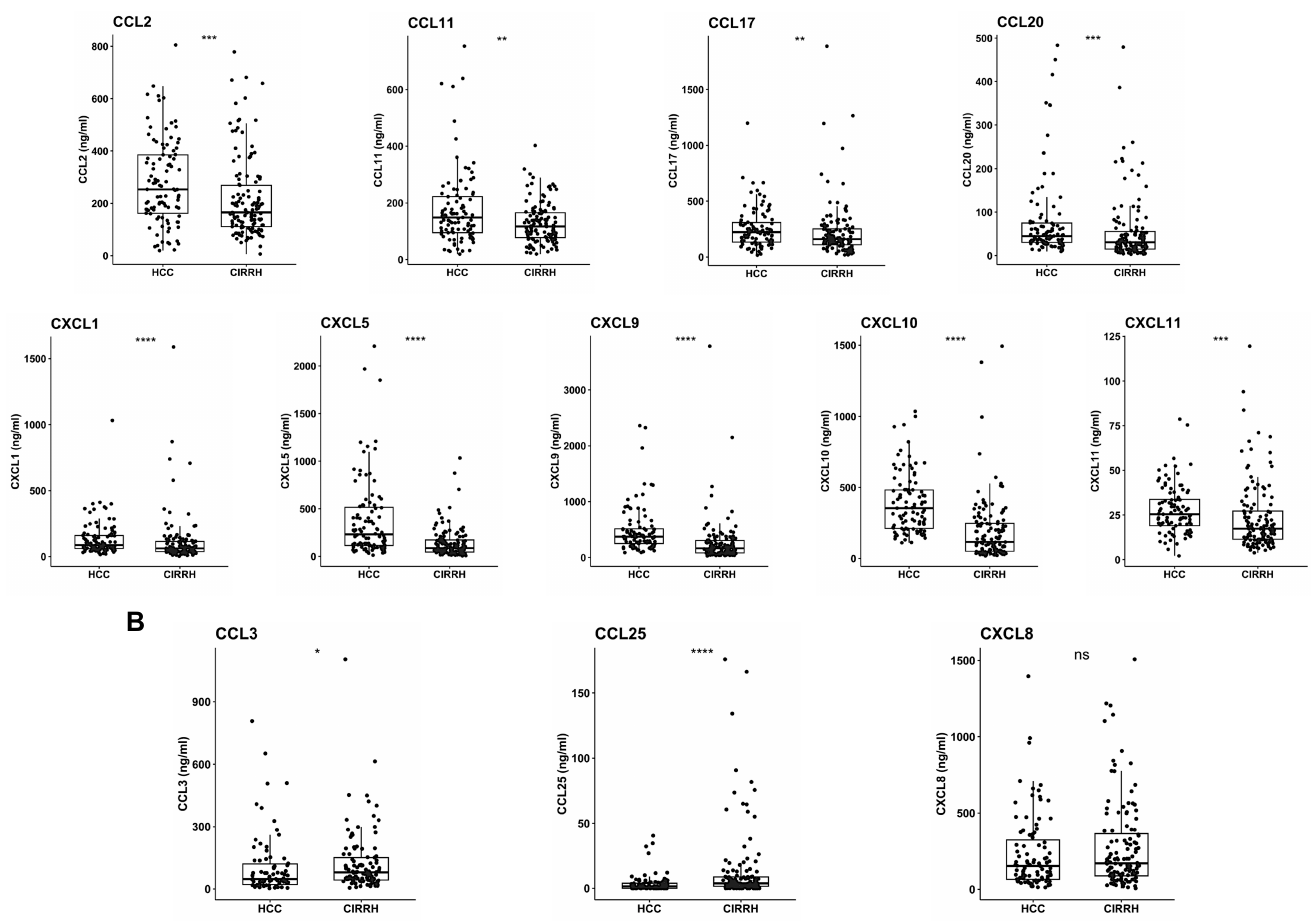
Figure 1. Inflammatory chemokine serum levels in patients with HCC or liver cirrhosis. Scatter dot plots with horizontal bars indicating median and IQR (ns p > 0.05, * p ≤ 0.05, ** p ≤ 0.01, *** p ≤ 0.001, **** p ≤ 0.0001). ( A ) Chemokines significantly upregulated in patients with HCC compared to cirrhotic patients without HCC. ( B ) Chemokines significantly downregulated in patients with HCC or without difference compared to cirrhotic patients without HCC. Abbreviations: CCL, chemokine C-C motif ligand; CIRRH, cirrhosis; CXCL, C-X-C motif chemokine ligand; HCC, hepatocellular